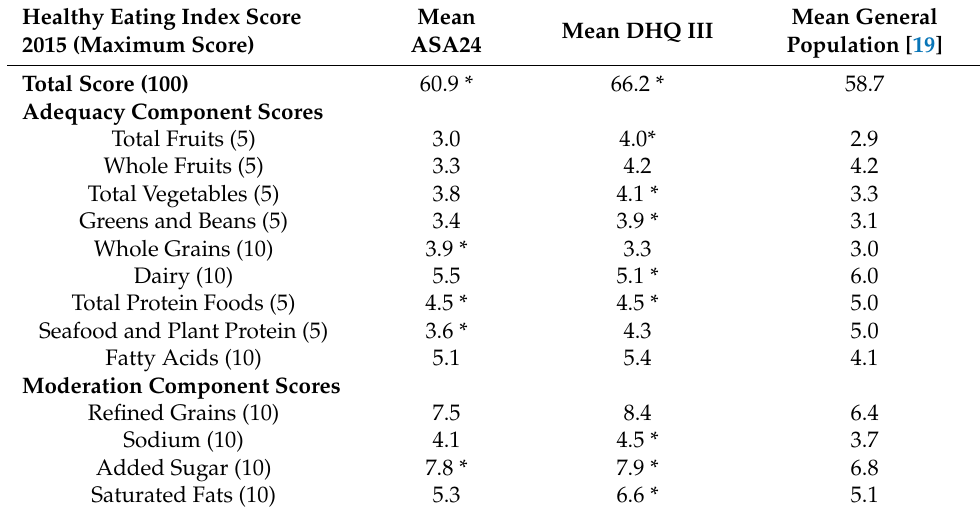
Table 2. Healthy eating index scores compared across diet questionnaire methods in 128 participants and the general population